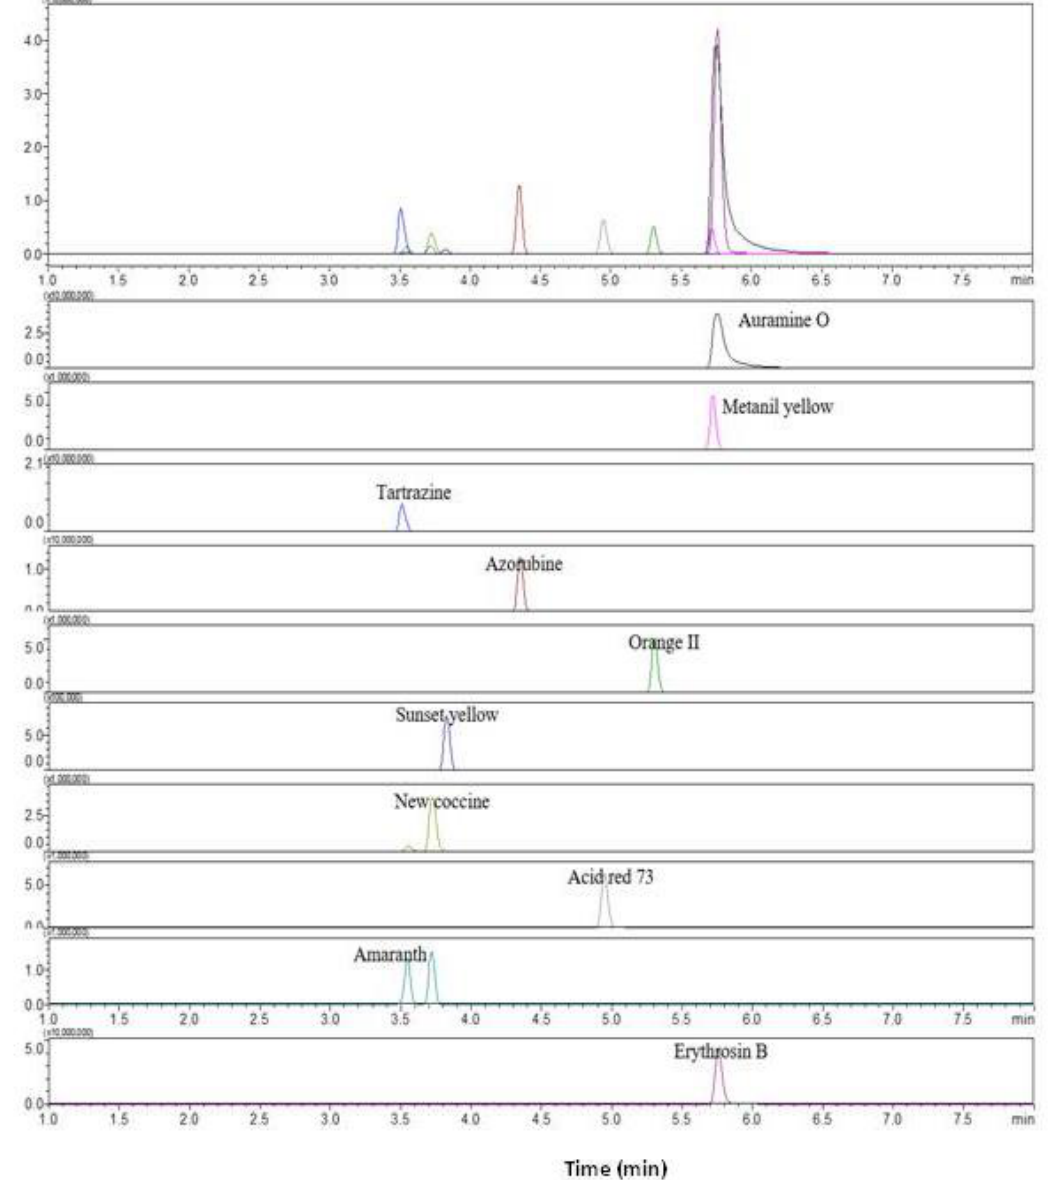
Figure 4. Total ion chromatography of LC-MS/MS for ten synthetic dyes extracted by the MRM conditions in the mixed standard synthetic dye solution: Tartrazine, m/z 467.1 > 198.0; Auramine O, m/z 268.0 > 147.1; Metanil yellow, m/z 352.2 > 1560; Amaranth, m/z 537 > 3120; New Coccine, m/z 398 > 120; Sunset yellow, m/z 398 > 120; Erythrosine, m/z 398 > 120; Azorubin, m/z 398 > 120; Acid red 73, m/z 398 > 120, and Orange II. m/z 398 > 120.